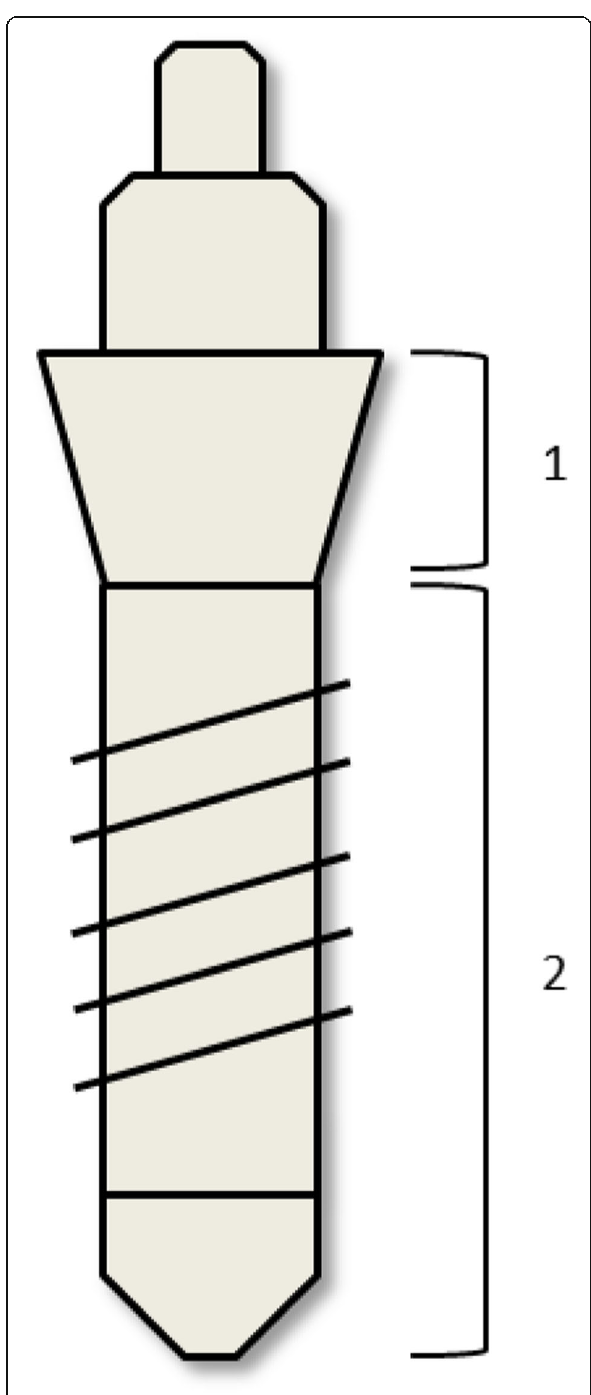
Fig. 1 Diagram of different implant areas used for sampling. 1) Machined (untreated) area. 2) rough (treated)